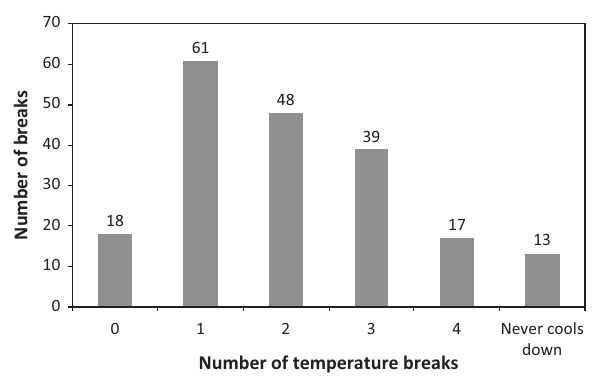
FIGURE 2: Number of breaks in the cold chain during the 2011/2012